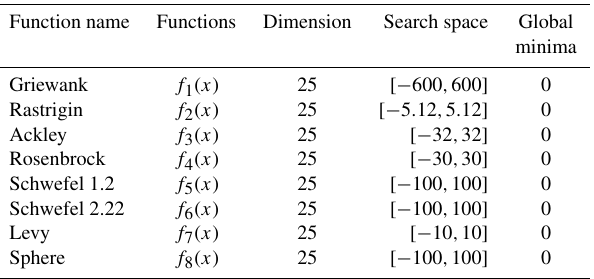
Table 2. Configuration of benchmarking functions